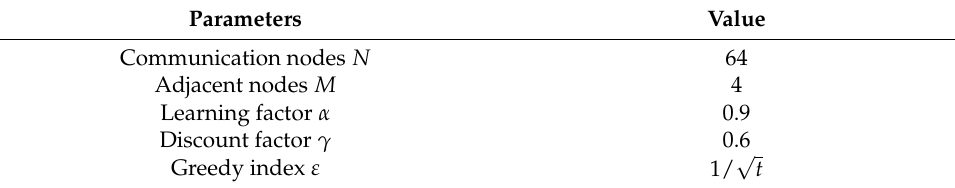
Table 1. Settings of model-related